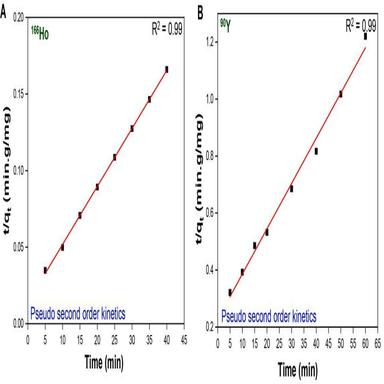
Fitting of the data to the pseudo second order kinetics model for adsorption of (A) 166Ho and (B) 90Y on nanoporous HA microparticles.